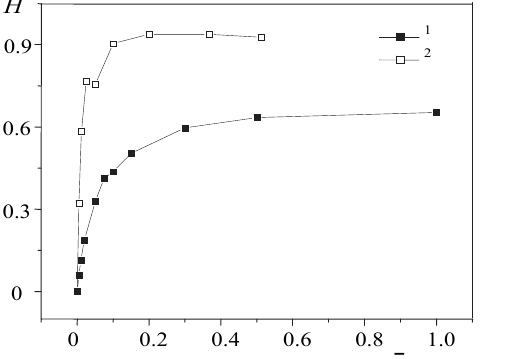
Figure 5: Dependence of the Shannon entropy values versus the relative number of loading cycles of the fatigue sensor: bending (1) and ʺ bending + torsion ʺ (2) loading